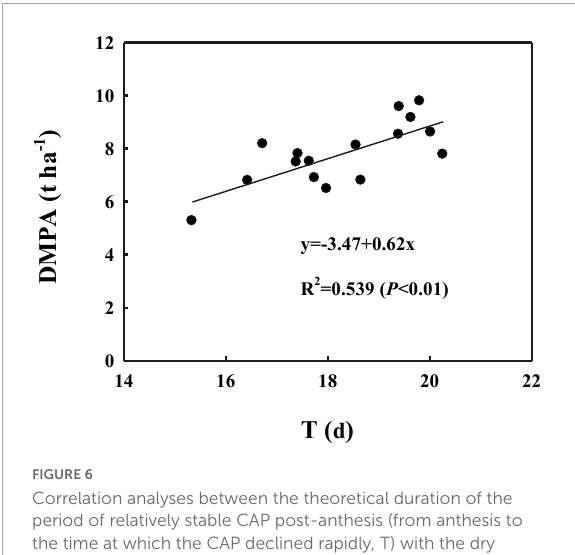
FIGURE6 Correlation analyses between the theoretical duration of the period of relatively stable CAP post-anthesis (from anthesis to the time at which the CAP declined rapidly, T) with the dry matter production amount post-anthesis (DMPA). Values are means of three replicates per